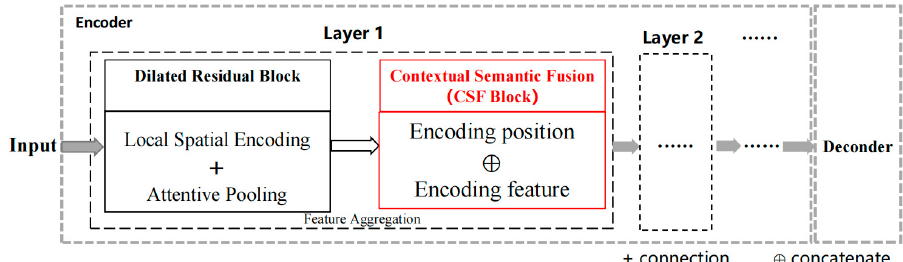
Figure 4. The structure in the feature aggregation module of each layer.